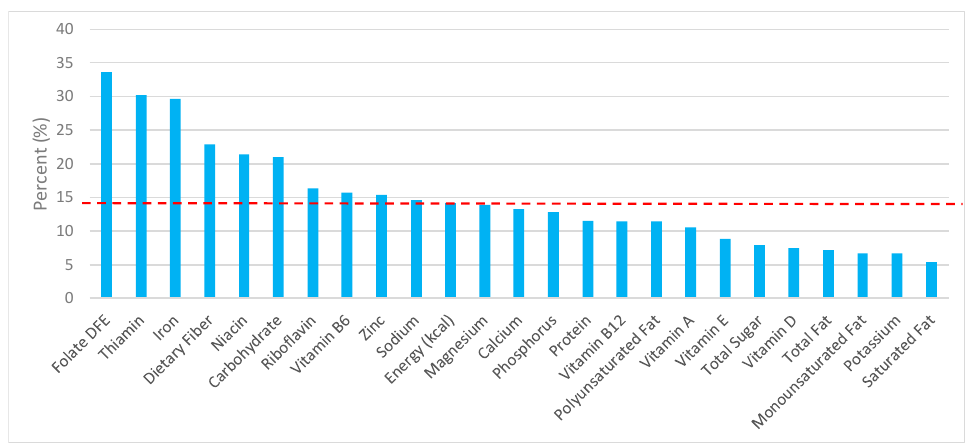
Figure 1. Grain foods sources of energy and nutrients using the National Health and Nutrition Examination Survey (NHANES) 2009–2012, for adults. Data are for all adults ≥ 19 years of age ( n = 10,697; males and females), Day 1 intakes; dashed red line represents the percentage of energy provided and nutrients that surpass energy (kcal) contribution. Thus, nutrients above the dashed red line show the food category provides a greater percentage in the diet to showcase meaningful nutrient density in the diet per day. DFE, dietary folate equivalents.